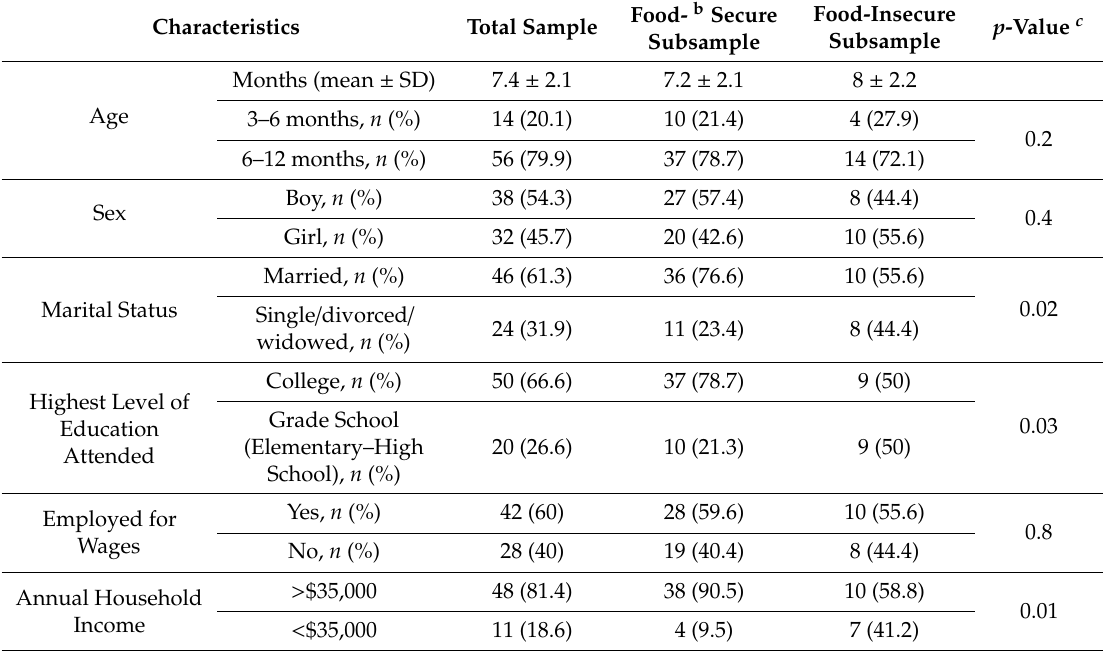
Table 3. Characteristics of food-secure and food-insecure infants and their caregivers included in this cross-sectional study examining food security and Native Hawaiian, Pacific Islander, and Filipino (NHPIF) a infant diet ( n =